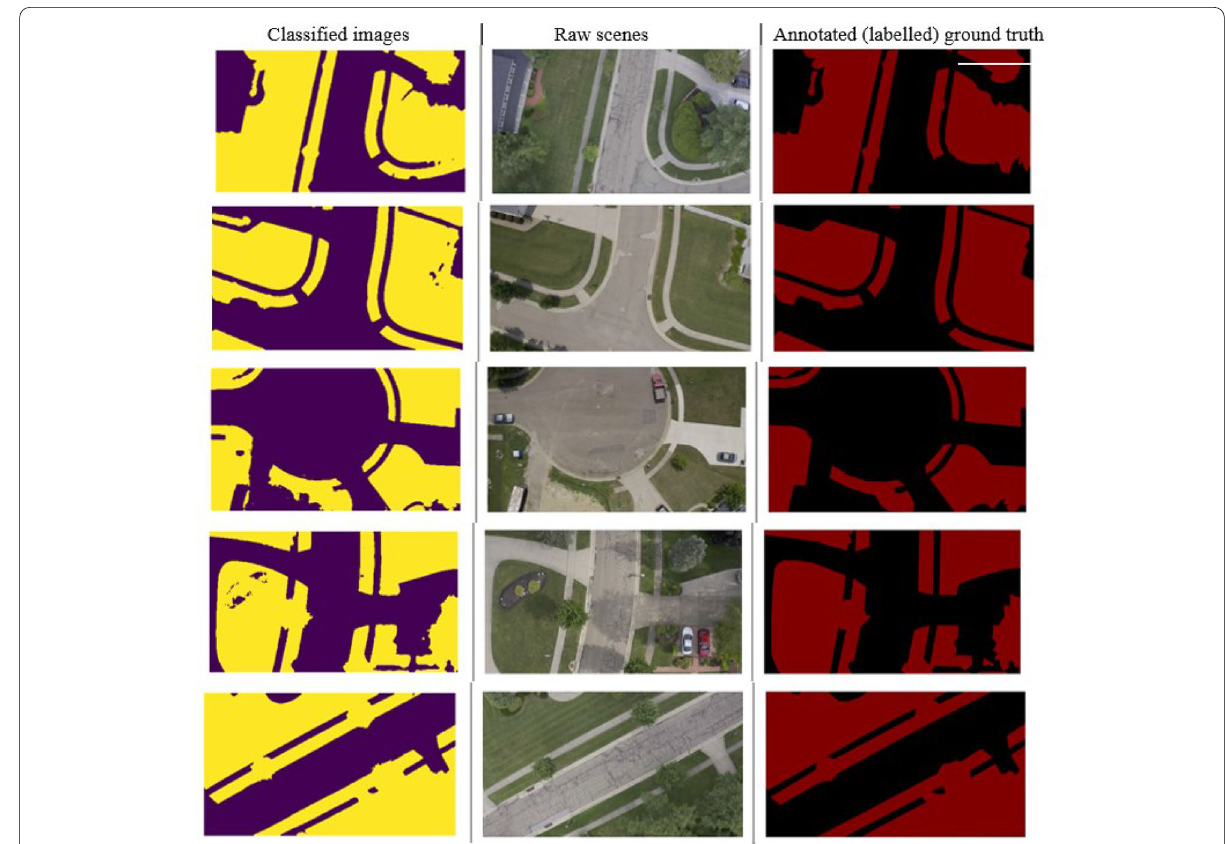
Fig. 7 The visual display of classification, raw scene, and the annotated ground truth images. The classified images are the segmentation results from the U-net. The greenness pixels are showed in yellow, and the background (non-greenness) pixels are showed in purple. The annotated (labelled) ground truth images are the test set. The ground truth greenness pixels are labelled with red color, and the background are labelled with dark color